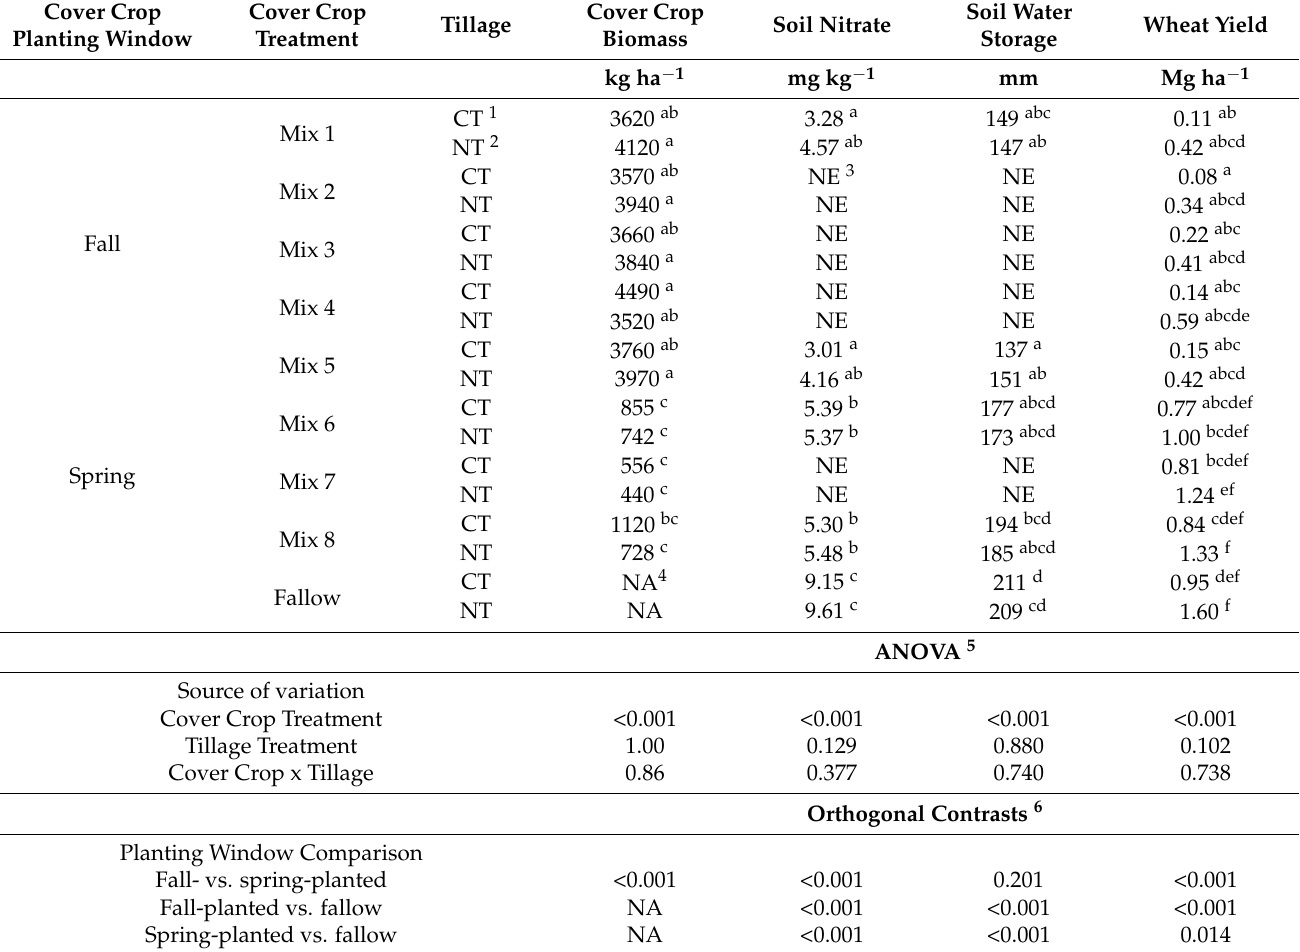
Table 5. Cover crop biomass, soil nitrate, soil water, and wheat yield data from the 2016–2018 cropping cycle of a field trial (T2) located at the Southwestern Colorado Research Center in Yellow Jacket, CO. Treatments are either a cover crop-winter wheat or fallow-winter wheat rotation. Values with different lowercase letters (by column) indicate differences to an alpha level of 0.05, as determined by Tukey-adjusted multiple